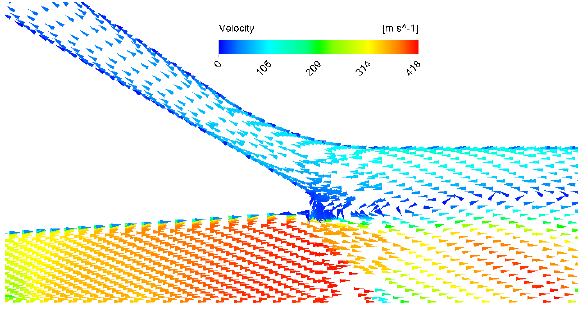
Fig. 15. Vector of Velocity magnitude for relative back- pressure p 4 /p 02 = 1.77, (172 kPa abs) in the vicinity of the motive